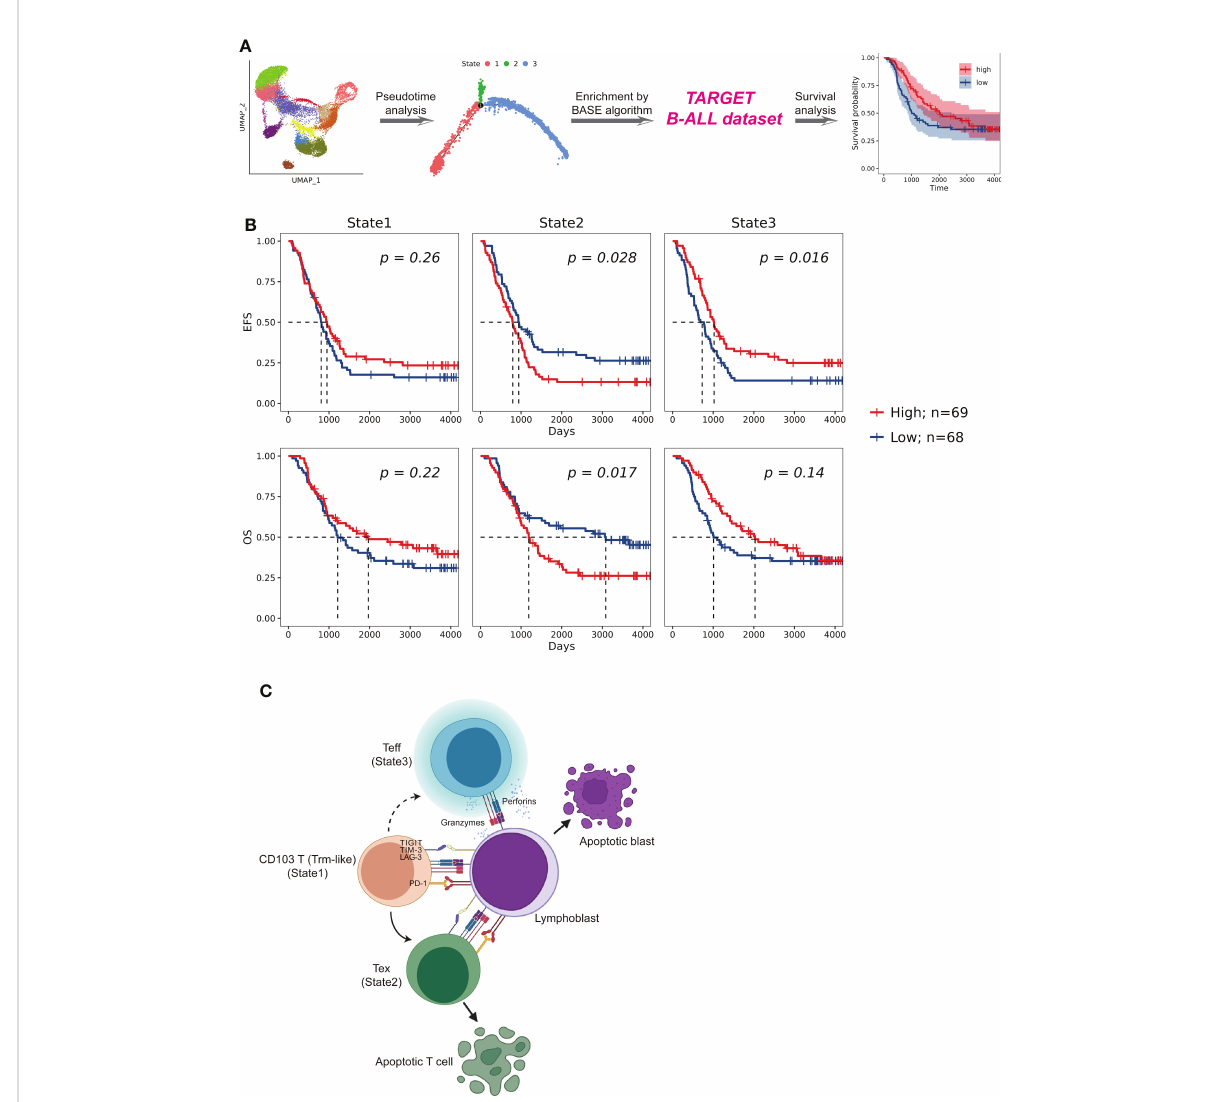
FIGURE 5 Patient survival impact comparison related to T cells in distinct cell fate trajectory states. (A). Schematic work fl ow of survival analysis based on the enrichment of CD4+ and CD8+ T cells in each state for patients enrolled in the TARGET (Therapeutically Applicable Research to Generate Effective Treatments) B-ALL database. The enrichment of T cells of each state in a patient was calculated by using BASE algorithm on the bulk- cell RNA-seq data from the corresponding individual. (B). Kaplan – Meier plots for the prognostic value of event-free survival (EFS) and overall survival (OS) according to the transcriptional signatures of each CD8+ T-cell state in patients from TARGET B-ALL dataset (n = 137). Patients were strati fi ed into high and low level based on the median of the transcriptional signatures for each CD8+ T-cell state. P value was determined by log-rank test. (C). Proposed Trm-like cell functional transition model in B-ALL